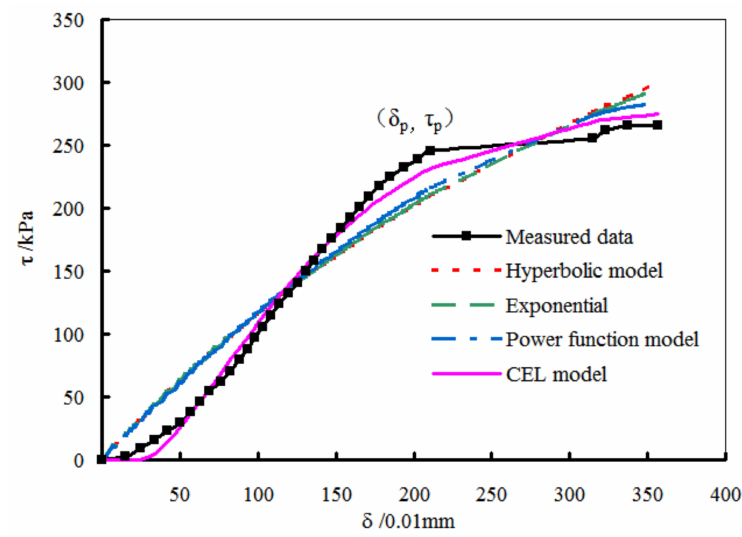
Figure 11. τ - δ curve under 300 kPa vertical pressure.